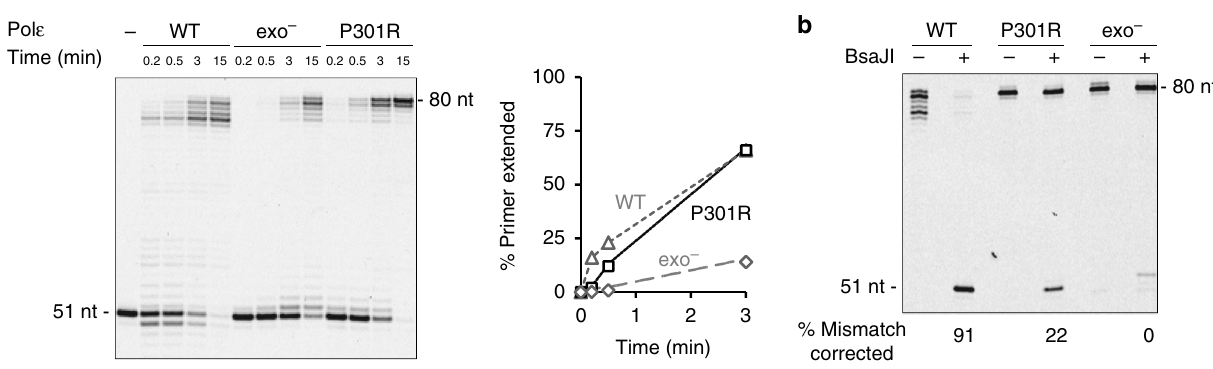
Fig. 4 Increased mismatch extension capacity of Pol ε -P301R. a DNA polymerase activity was assayed on P51T/T80 oligonucleotide substrate containing a terminal G-T mismatch, and the fraction of primer extended ( ≥ 52 nt) was quanti fi ed. The polymerase and DNA substrate concentrations are as in Fig. 3a. Representative of seven independent experiments. b Pol ε variants were incubated with the P51T/T80 substrate for 30 min, and relative ef fi ciency of mismatch extension vs. proofreading was determined by BsaJI digestion of the reaction products. The appearance of 51-nt restriction fragment indicates that the mismatch has been corrected by the polymerase. The 80-nt fragments resistant to BsaJI digestion represent products of mismatch extension. Representative of two independent experiments. Source data are provided in a Source Data fi